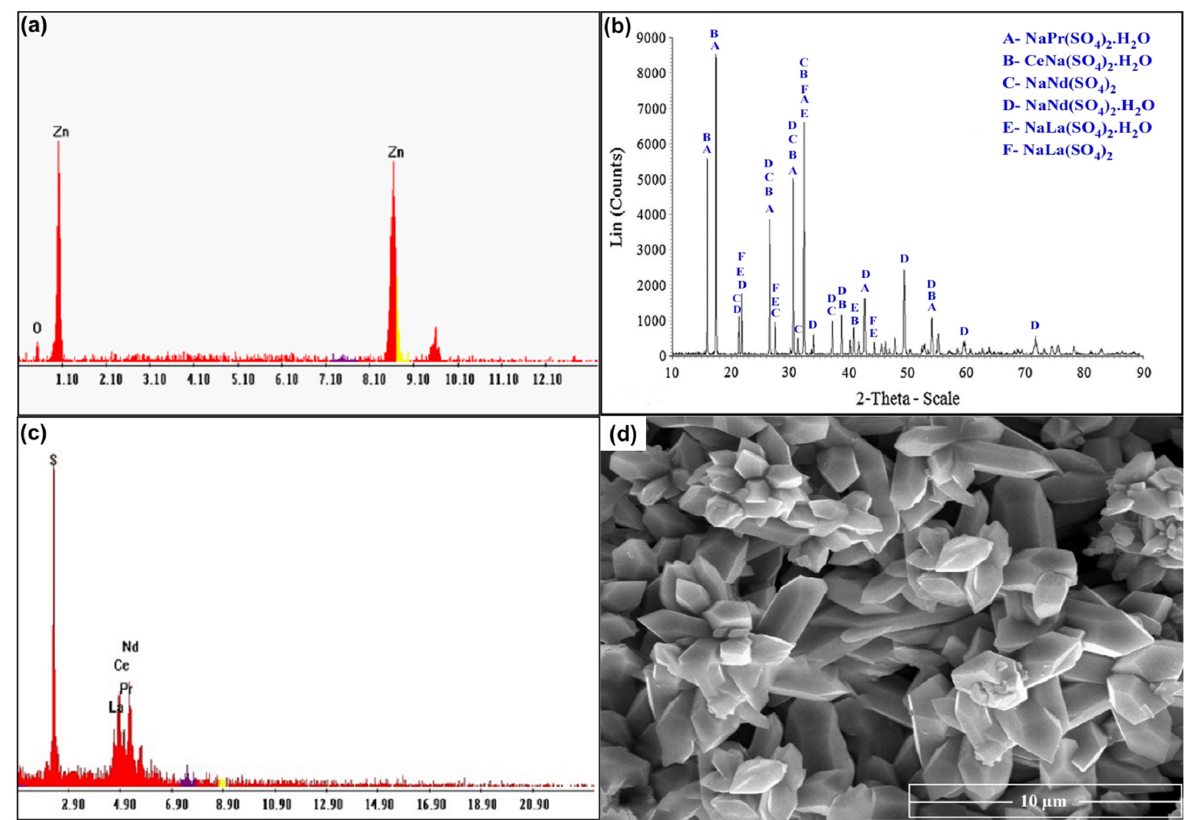
Figure 14. ( a ) EDX spectrum of ZnO product; ( b ) XRD spectrum of RE sulfate salts; ( c ) EDX spectrum of REE product; ( d ) SEM image of REE product.